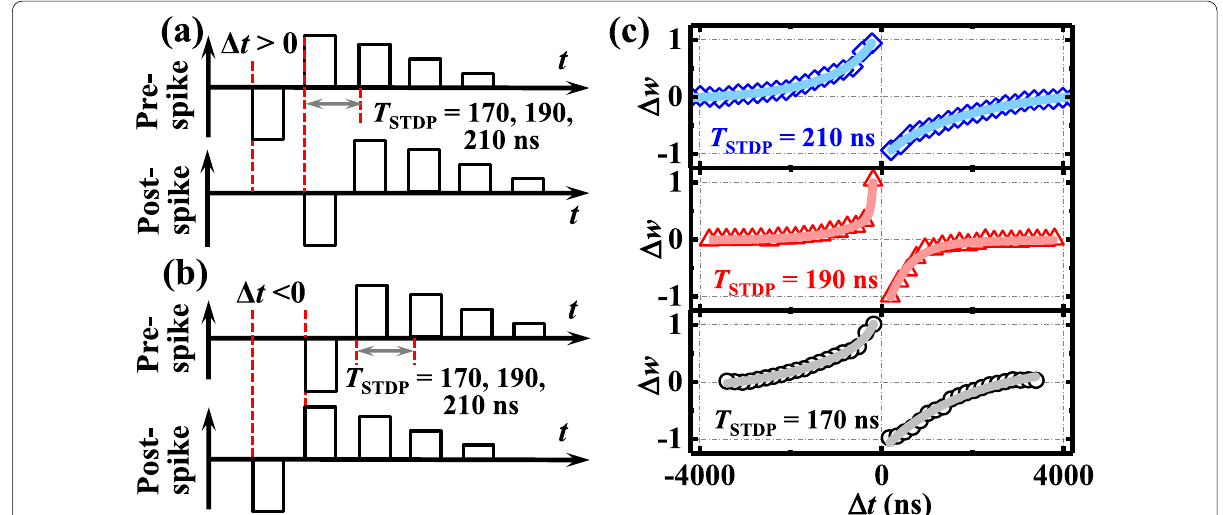
Fig. 6 a and b Spike timing waveform for the implementation of STDP. c Measured STDP curves in the amorphous HfO 2 synaptic transistor with different spike periods ( T 170, 190, and 210 =